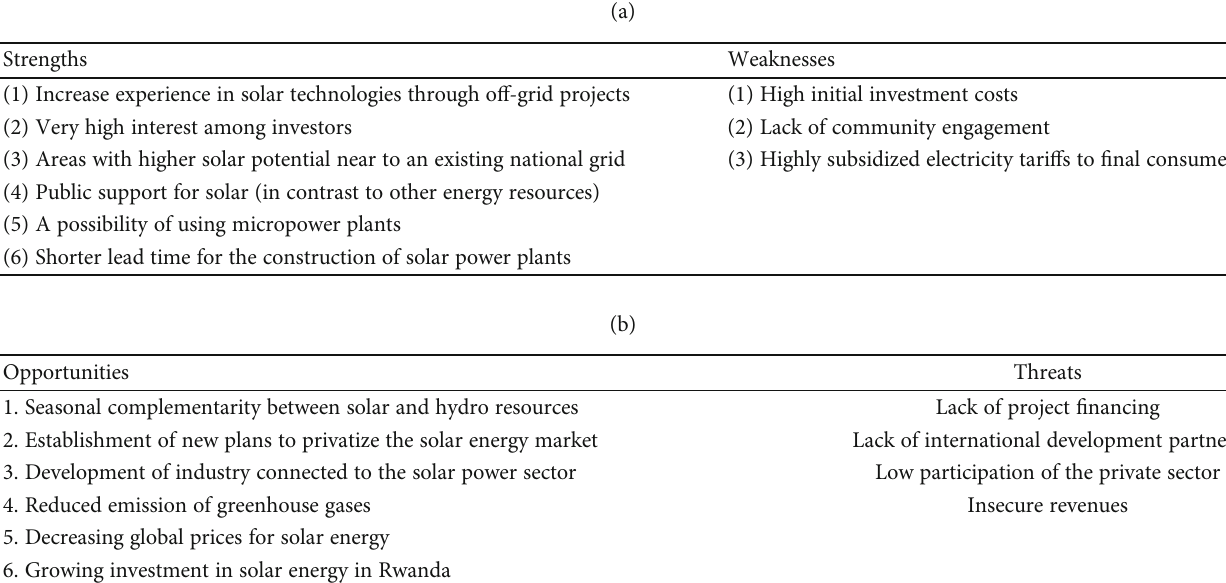
Table 7: Internal and external factors identi fi ed for SWOT analysis.